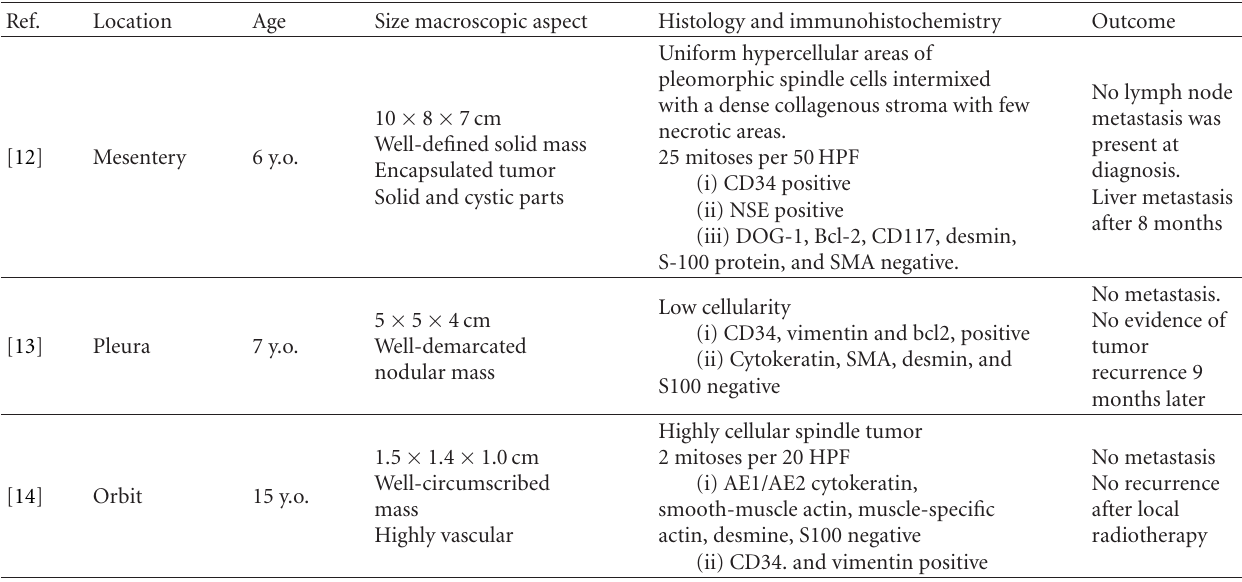
Table 2: Characteristics of the paediatric cases reported in the literature.